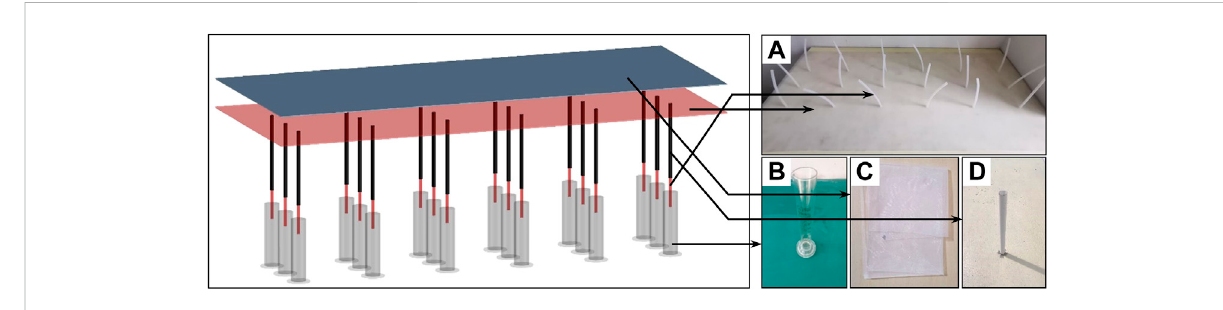
FIGURE 6 Waterleakagemonitoringmoduleoftheworkingface. (A) Siliconepadandsiliconeaqueducts, (B) measuringcylinders, (C) strainer,and (D) PVC casing